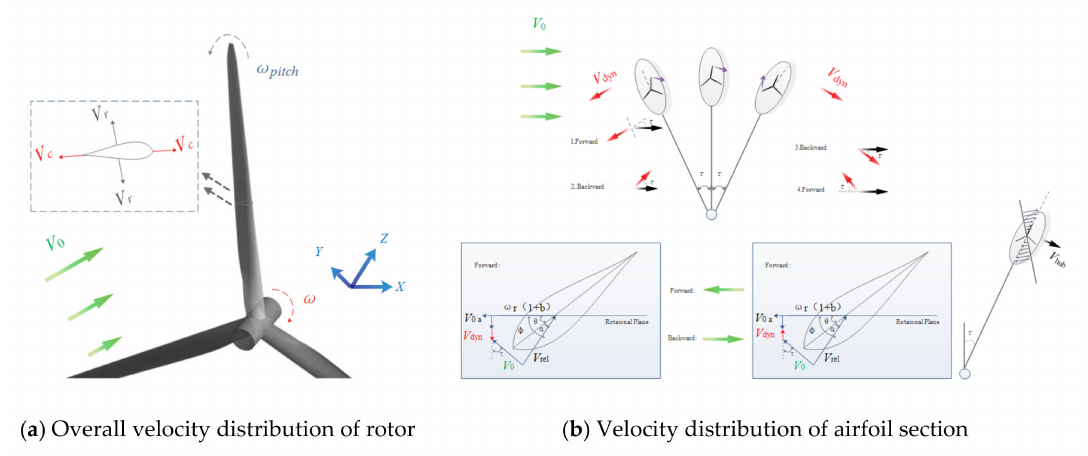
Figure 11. Velocity diagram under pitch